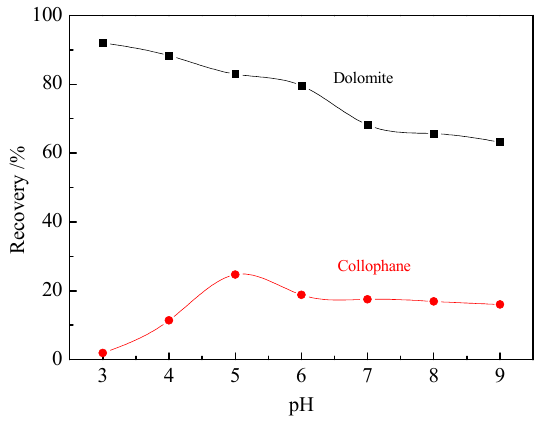
Figure 8. Effect of pH on zeta potential.